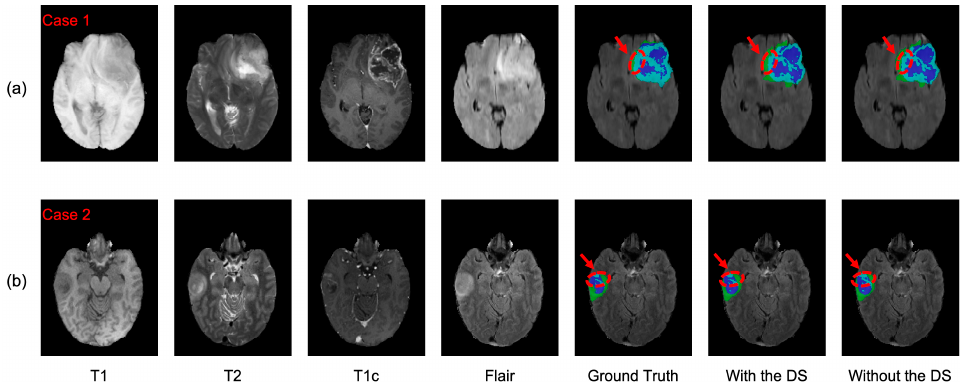
Figure 10. The visualized segmentation results of the proposed AABTS-Net and the AABTS-Net without DS. ( a , b ) represent the different visualized cases. From left to right: T1, T2, T1c, Flair, Ground truth, the result segmented by AABTS-Net with the DS and the result segmented by AABTS-Net without the DS.